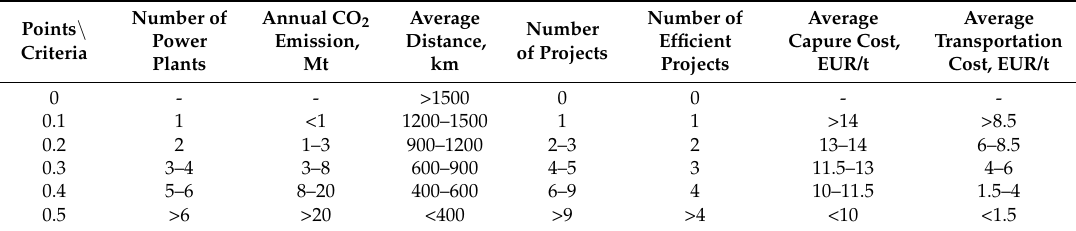
Table 2. Interval scale to rank regions according to their potential as CO 2 sources.